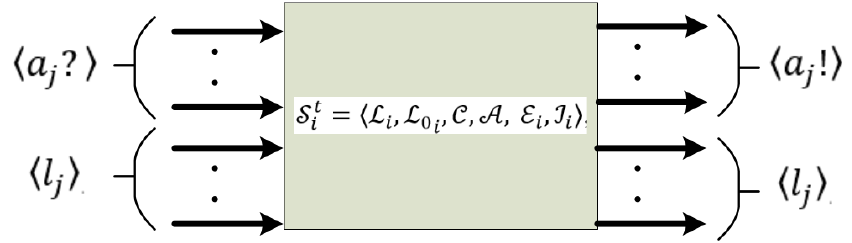
Figure 1. A representation of timed automata as the members of a network.